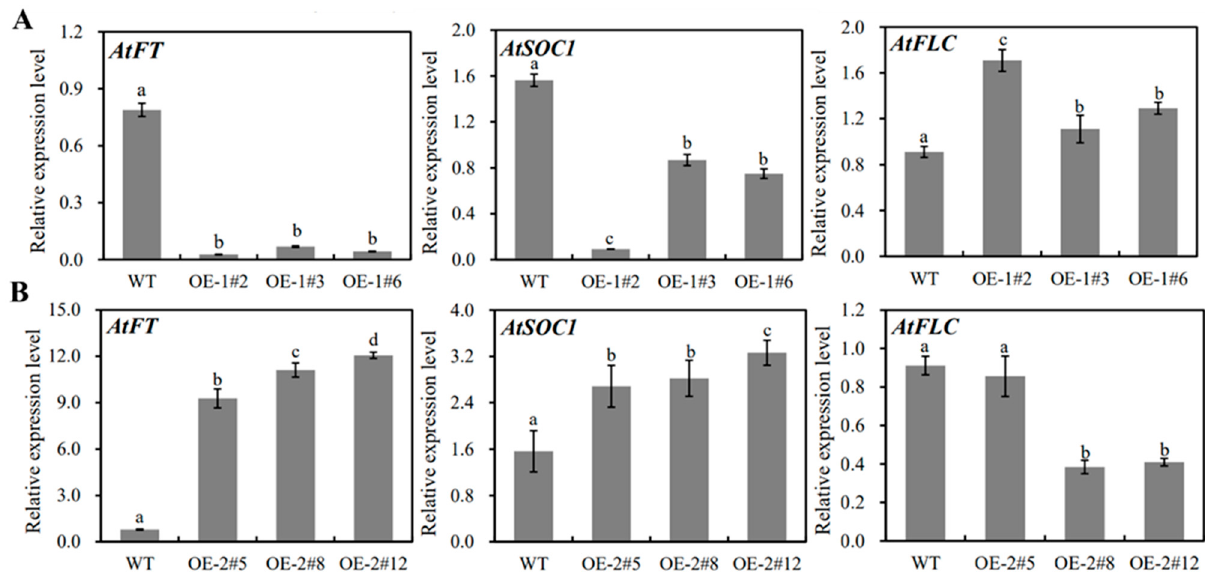
Figure 6. Expression level analysis of endogenous genes in Arabidopsis . ( A ) Expression of AtFT, AtSOC1 , and AtFLC in 35S:: MiSVP1 transgenic plants. ( B ) Expression of AtFT , AtSOC1 , and AtFLC in 35S:: MiSVP2 transgenic plants. Relative expression level was determined by comparing the expression levels of AtFT , AtSOC1 , and AtFLC with the expression level of AtACTIN . Duncan’s multiple range test was used to analyze the significance of differences among multiple groups of samples, and p < 0.05 indicated a significant difference. The error bars represent the standard error of the mean (± SE) among three replicates of the same sample.